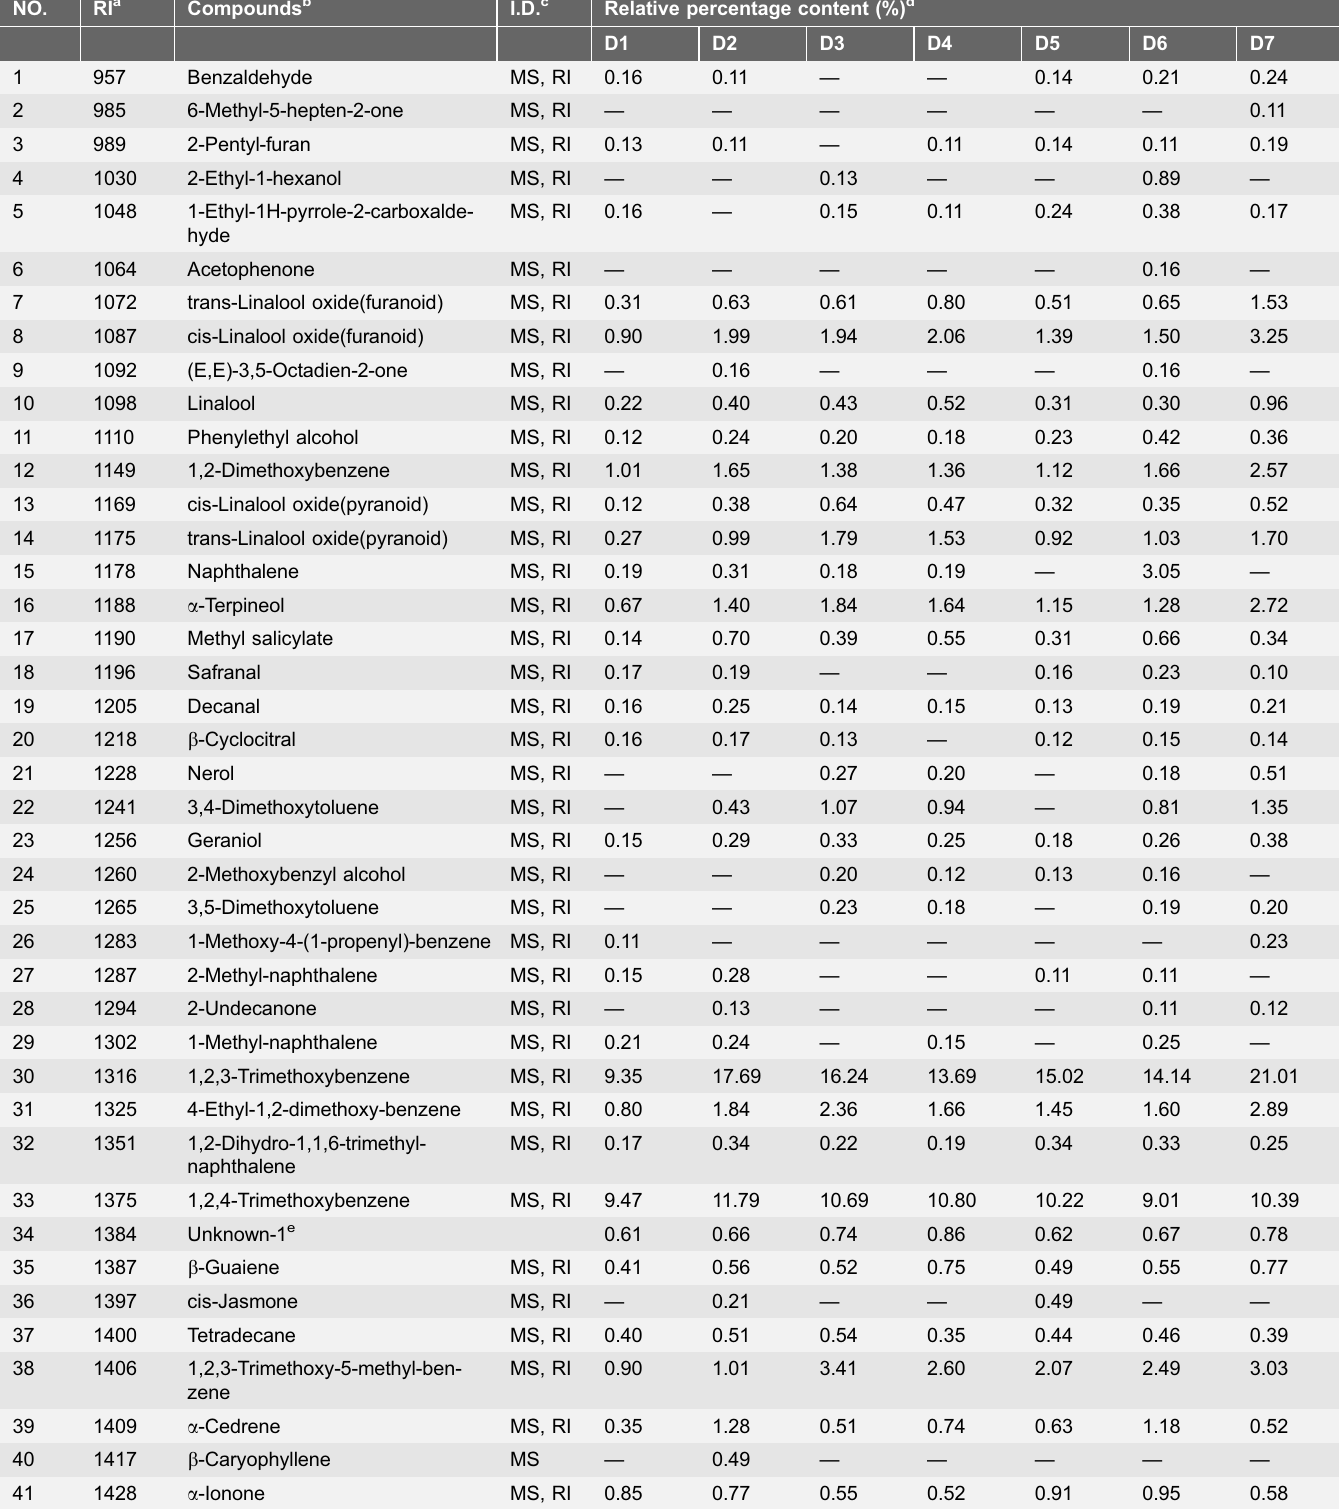
Table 3. GC-MS analysis results of volatile compounds in 7 Dayi Pu-erh tea